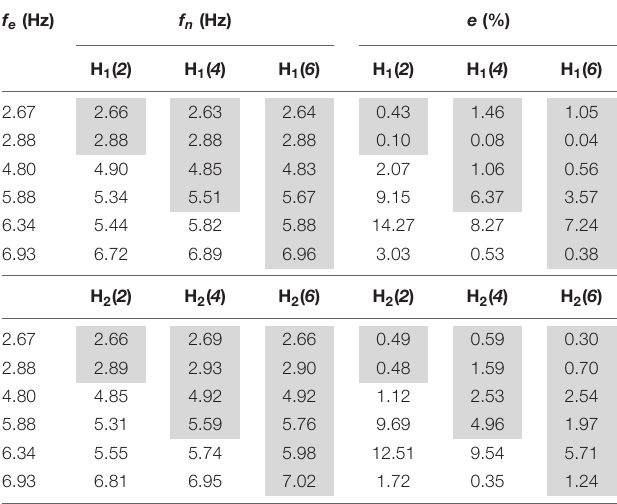
e denotes the percentage errors between experimental and numerical